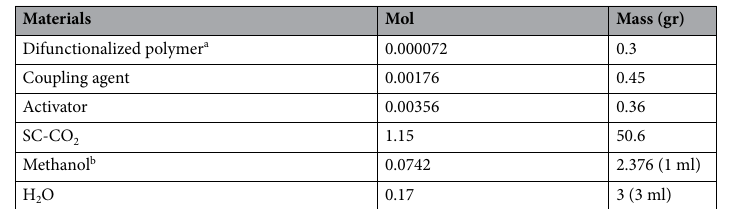
Table 3. Amount of raw materials used for the synthesis of cPNIPAAM in emulsion of CO 2 /Water. a Difunctionalized polymer was synthesized in condition of P = 23 MPa during 12 h, T = 70 ◦ C , W